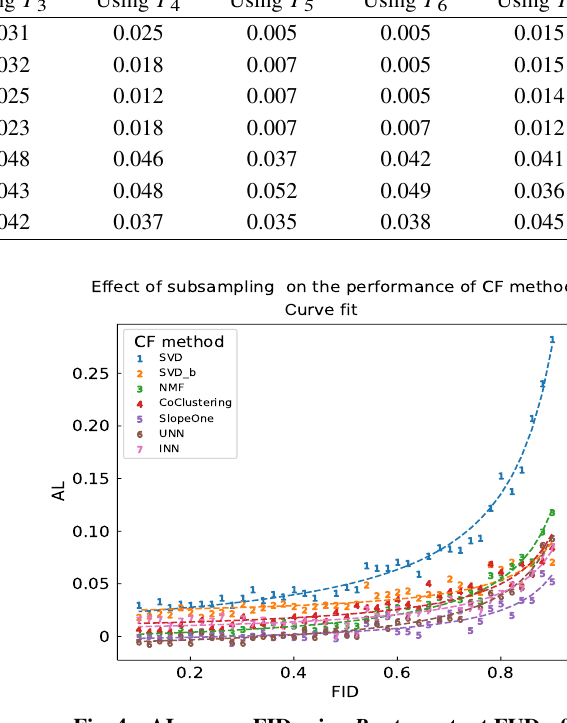
Fig. 4 AL versus FID using P 1 at constant FUD =0.7.